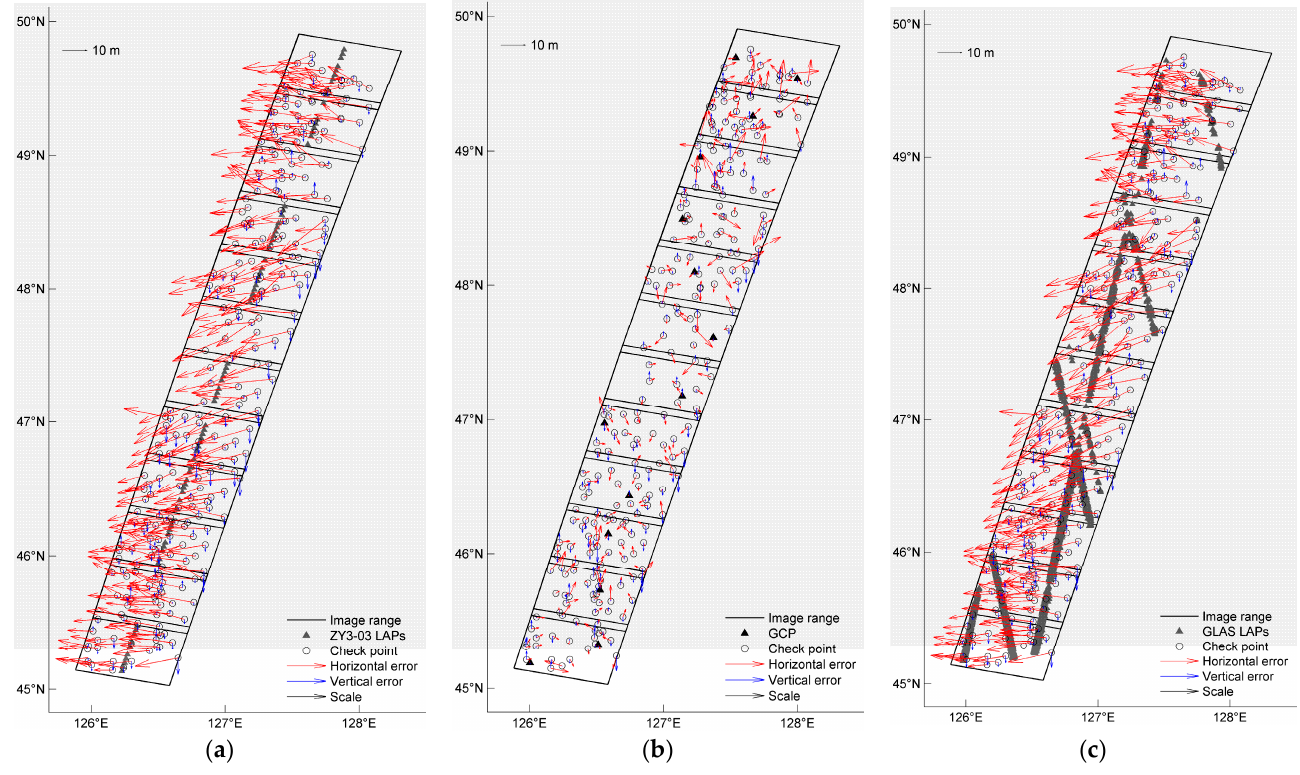
Figure 10. Residuals of integrated processing of the ZY3-03 experimental data. ( a ) First group; ( b )